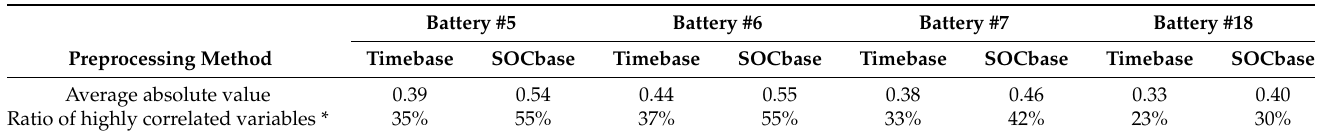
Table 1. Average absolute values of the Pearson correlation coefficient and the ratio of highly correlated variables according to the data processing method (sampling number = 20).